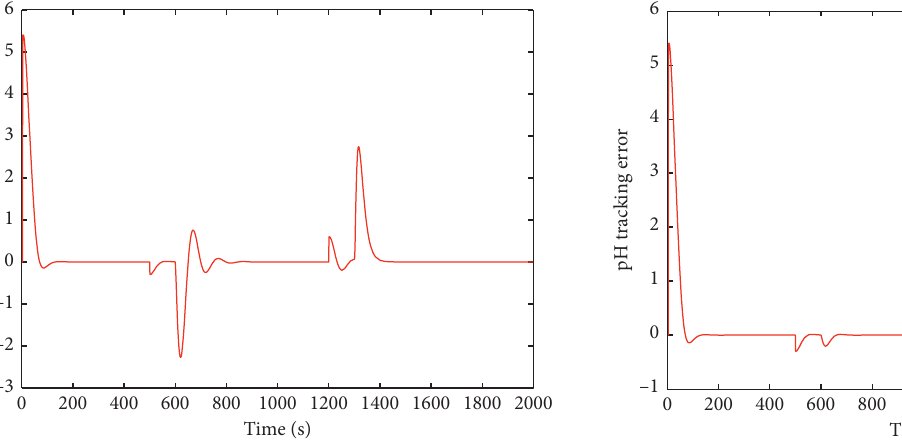
Figure 5: pH tracking error curve.